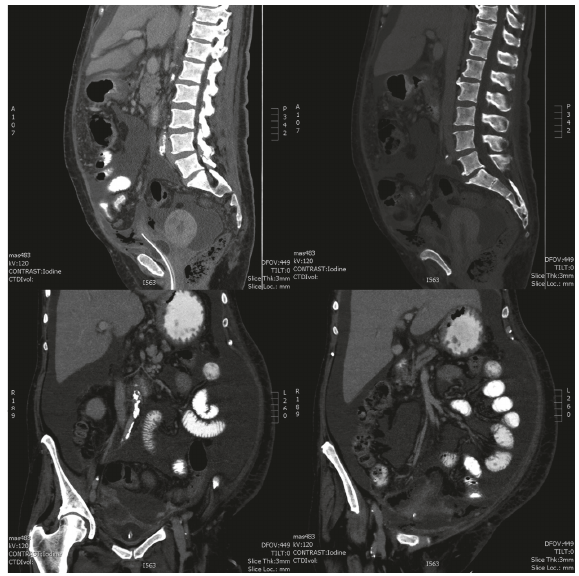
Figure 2: Coronal/sagittal abdominal CT scan images suggesting bladder rupture and diffuse peritonitis.